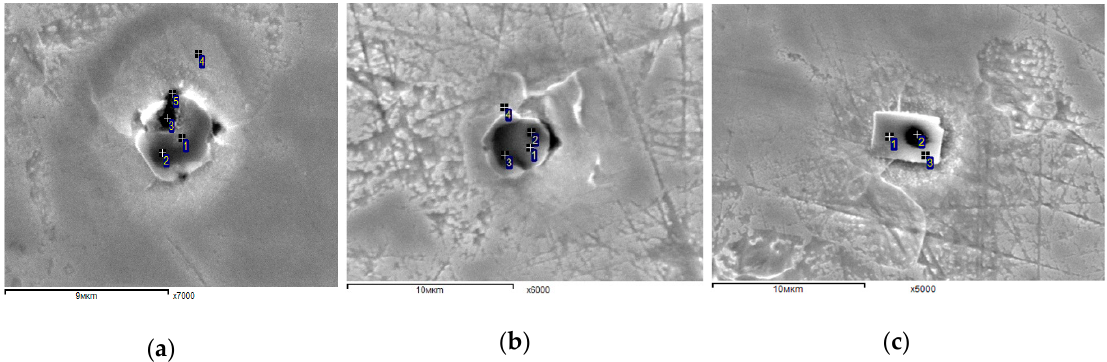
Figure 9. Typical corrosion active non-metallic inclusions observed after etching of hot rolled oil-pipeline steel samples: ( a ) Type III (CAM + CS), ( b ) Type V (CAM + CS + TN) and ( c ) Type VI (TN).